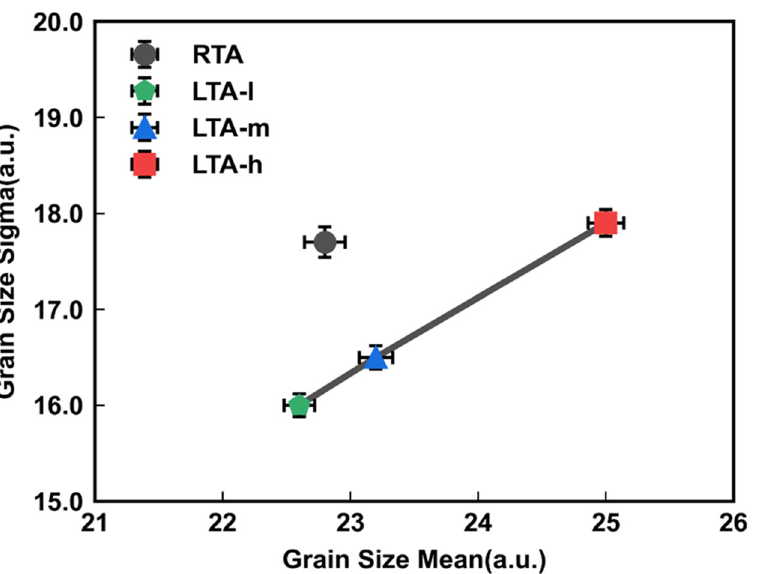
Figure 6. The correlation between grain size mean and grain size sigma of the Poly-Si channel with different thermal conditions, RTA, LTA-l, LTA-m, and LTA-h. The bars represent mean values, with the error bars showing standard deviation.